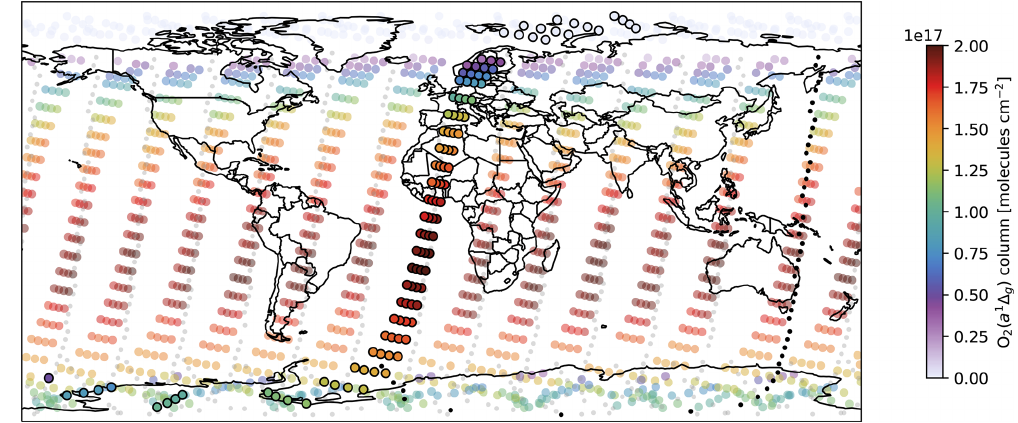
Figure 8. Large symbols are colored by the O 2 (a 1 (cid:49) g ) column number density retrieved from SCIAMACHY nominal limb orbits (nos. 41010–41023) on 3 January 2010. A single SCIAMACHY orbit (no. 41015) is highlighted in opaque colors with a black edge. Small gray symbols mark the temperature sounding locations from MIPAS that share orbits with SCIAMACHY. A single MIPAS orbit (no. 41023) is highlighted in black.